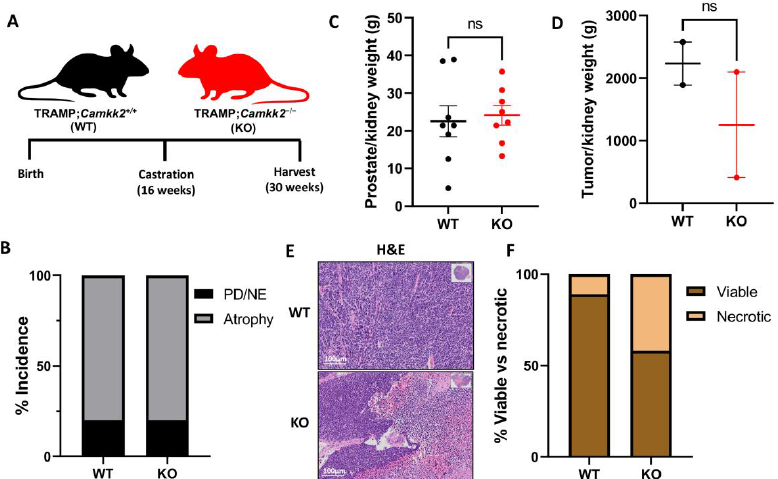
Figure 2. Camkk2 knockout increases tumor necrosis in castrated TRAMP mice. ( A ) Schema for mouse experiment. ( B ) % atrophied prostate and poorly differentiated or neuroendocrine (PD/NE) cancer (WT n = 10, KO n = 10). ( C ) prostate (WT n = 8, KO n = 7) and ( D ) tumor (WT n = 2, KO n = 2) weight normalized to kidney weight. ( E ) Representative images of prostates and tumors. ( F ) % coverage of viable vs necrotic cells in tumors (WT n = 2, KO n = 2) (Fisher’s exact test: p < 0.0001). ns = not significant by t